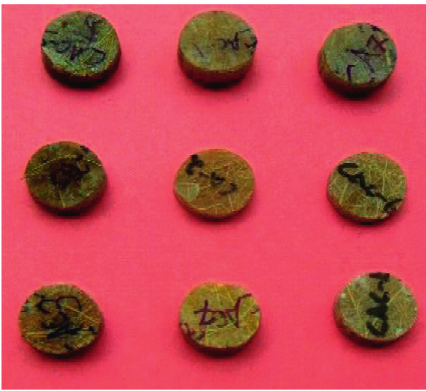
Figure 2: Photographic image of abrasion test specimen.